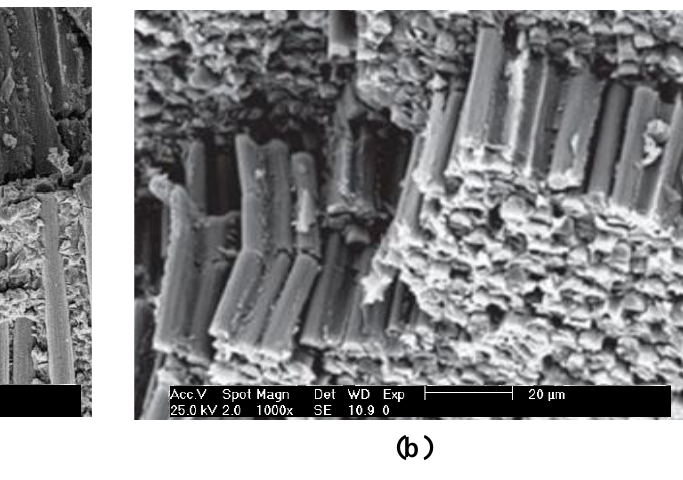
Figure 2. SEM observations after failure of SBS coupons at 120 °C. ( a ) PPS/CF; and ( b ) PPS/IF-WS (1.0 wt %)/CF 2